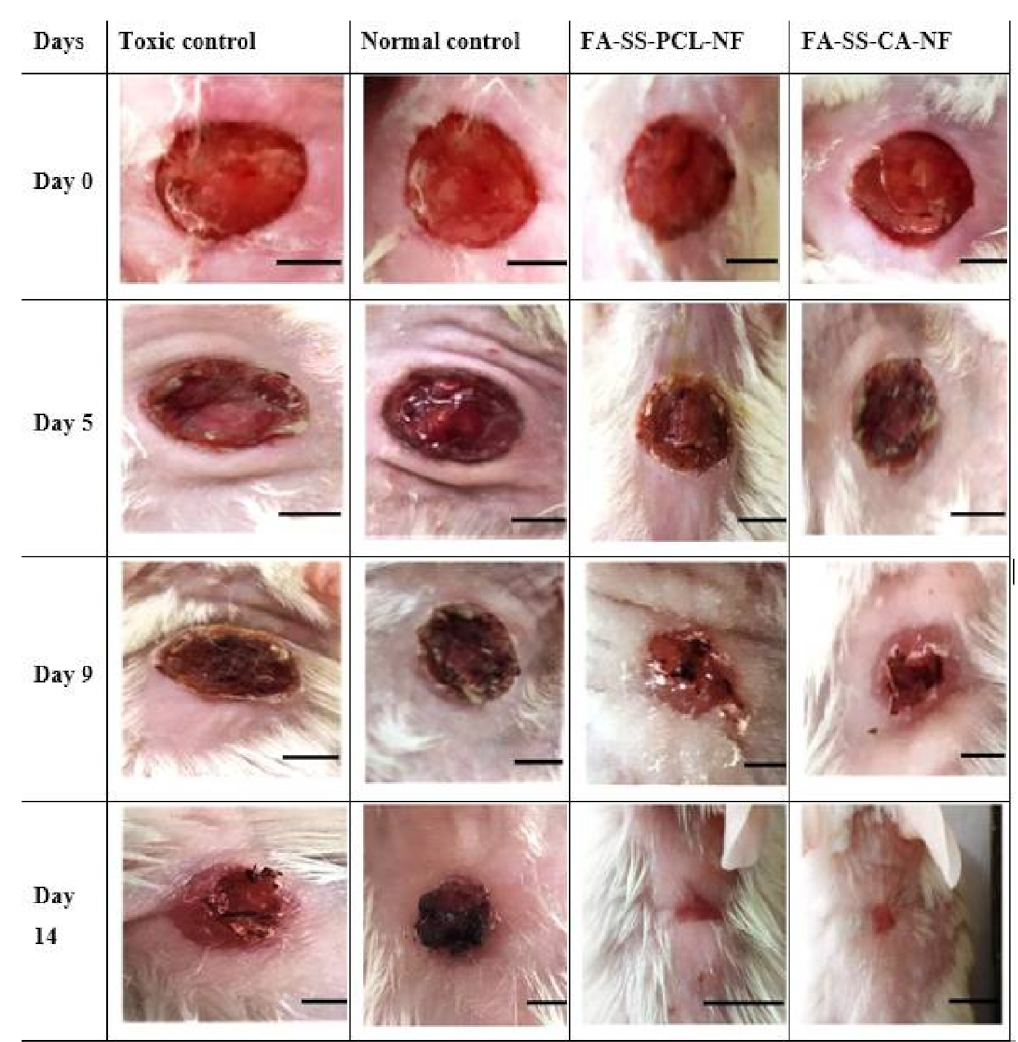
Figure 14. Images of wound healing in streptozotocin-induced diabetic rats on days 0, 5, 9, and 14 day after treating animals with TC (toxic control), NC (normal control), or formulation batches